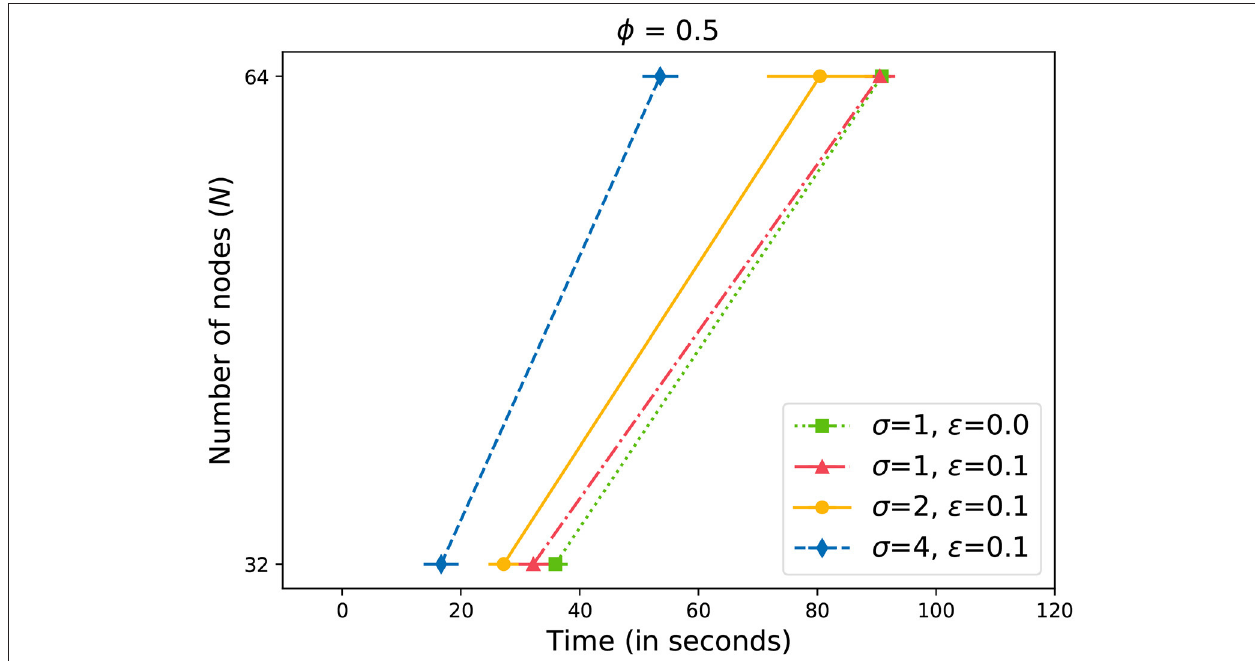
FIGURE 6 | Time to gossip a message with 10% failed nodes.